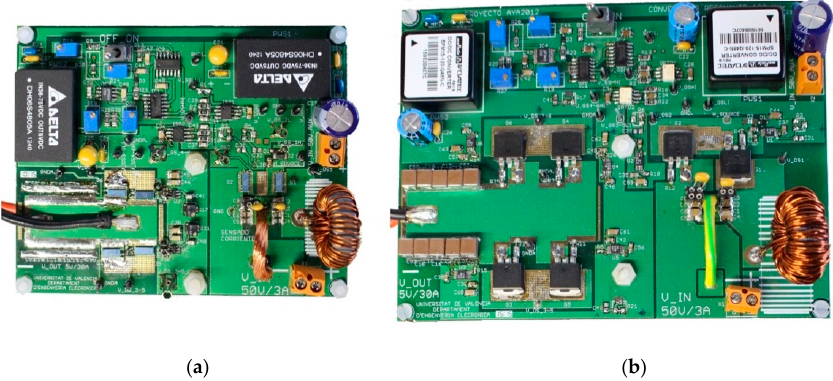
Figure 16. Experimental main waveforms of the IBC working at 1 MHz. i is the primary current (5 A/div), Vds _GAN1 is the drain to source of GAN1 (20 V/div), Vds _GAN2 is the drain to source of GAN2 (20 V/div) and Vgs _GAN3 is the gate to source of GAN3 working as synchronous rectifier (5 V/div). Time base: 200 ns/div. 6. Experimental Results In the previous theoretical analysis, the only parasitic capacitances considered charged/discharged during the gap state were those of the half-bridge transistors. However, other smaller parasitic capacitances are charged/discharged, whose values were previously neglected.